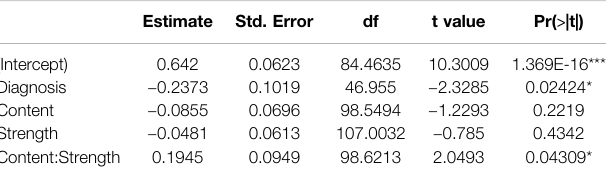
TABLE 2 | Coef fi cient table of the model used to probe the effect of depression diagnosis(Diagnosis; 0 (cid:1) nodepression diagnosis,1 (cid:1) depression diagnosis), content (Content; 0 (cid:1) sacri fi ce, 1 (cid:1) save), and strength (Strength; 0 (cid:1) weak, 1 (cid:1) strong) on gazing during initiating utterances. The marginal R 2 (Nakagawa and Schielzeth, 2013) for the model was 0.09 while the conditional R 2 was 0.58, indicating that the fi xed effects explained 9% of the variation. Estimate Std. Error